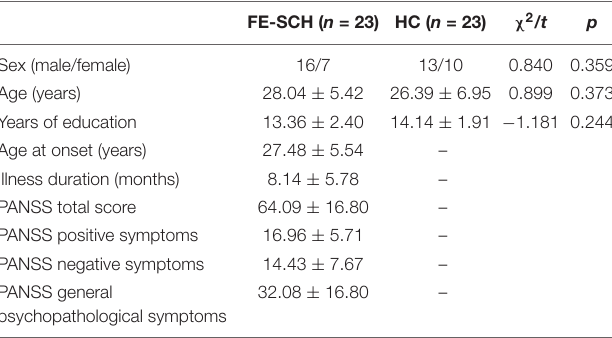
TABLE 1 | Demographic and clinical characteristics of all participants (Mean ±